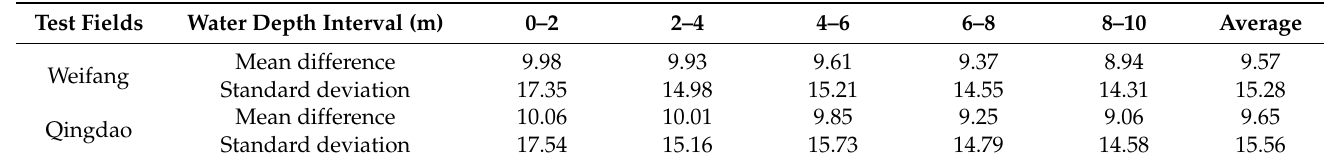
Table 3. Difference in amplitude between the fitted waveform and the signal segment at different depths at the two test